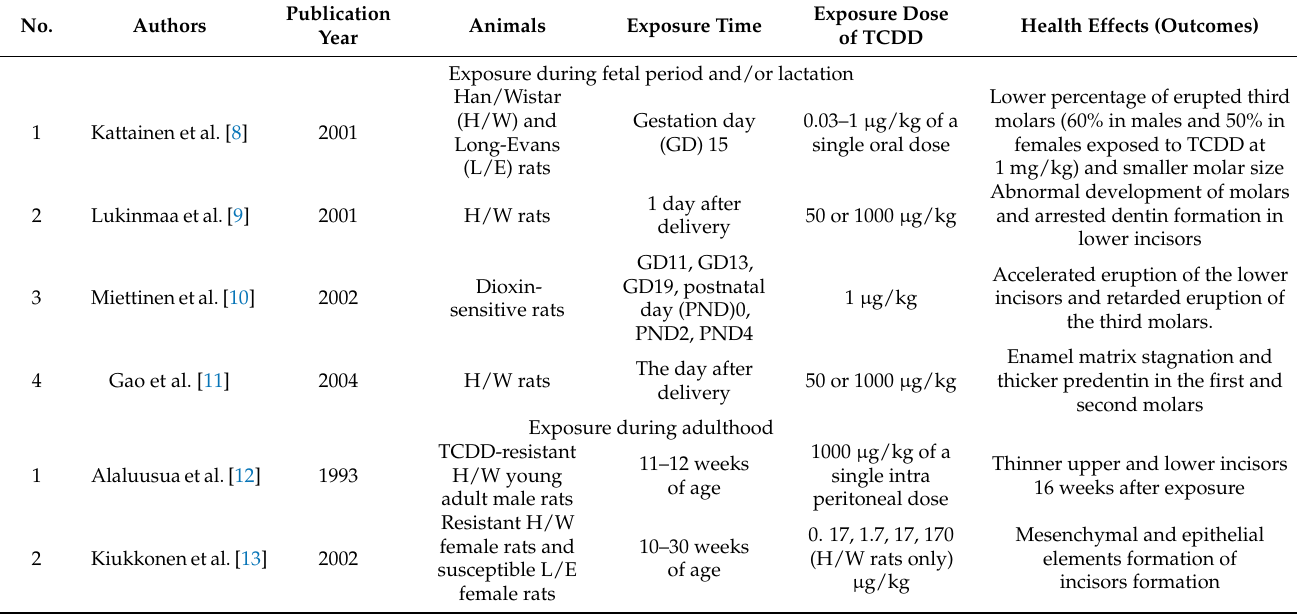
Table 1. Effects of TCDD on teeth in